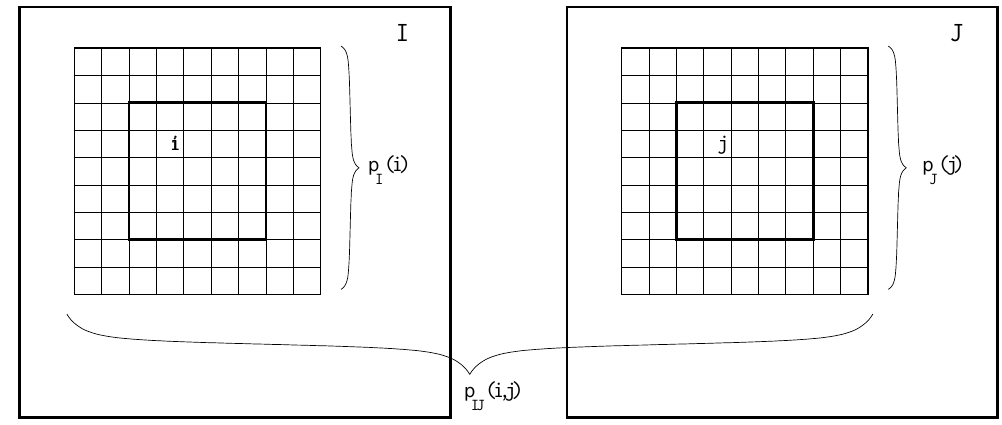
Figure 1. Calculation of the marginal and joint